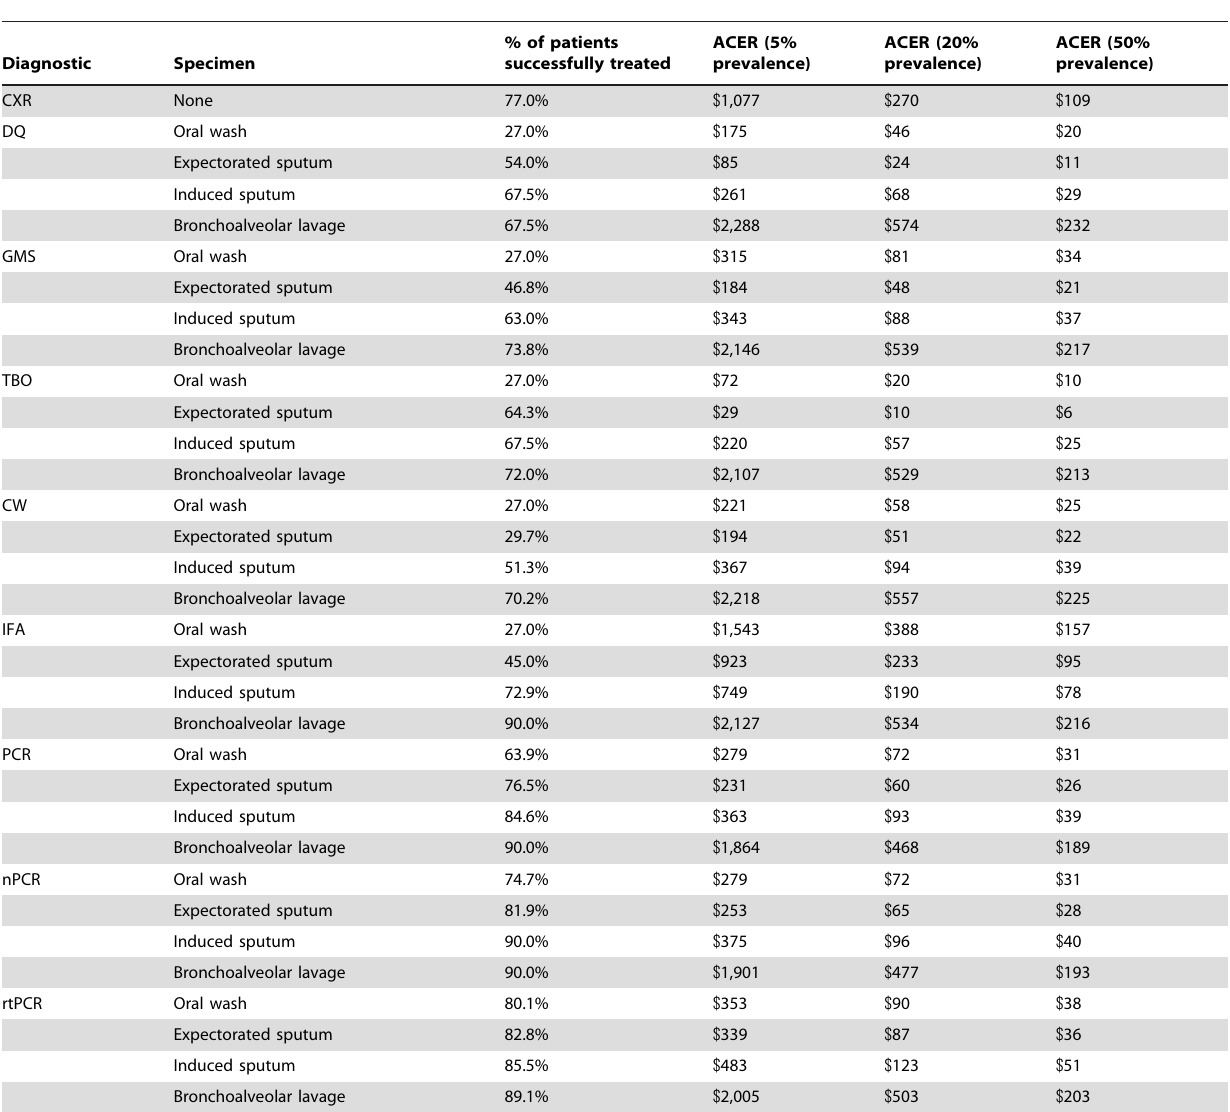
Table 2. Model outputs: Average Cost effectiveness ratio (ACER) (total diagnostic and treatment cost per life-year gained) for each diagnostic